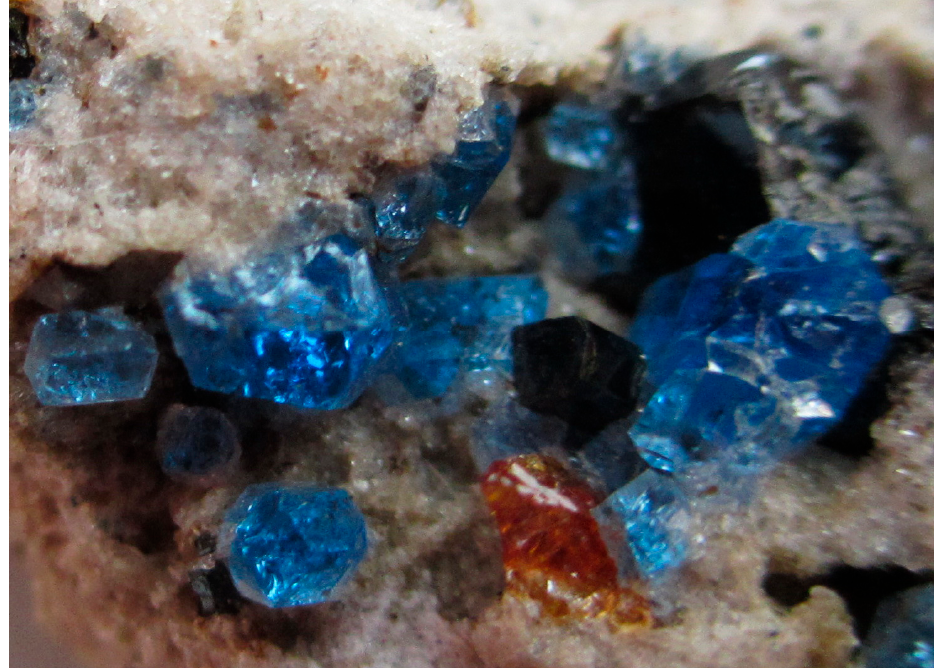
Figure 5. Crystals of haüyne (blue) in association with titanite (orange) and amphibole (black) on sanidinite. The Hn7981 sample. Field of view width: 8 mm. Photographer: Nikita V. Chukanov.